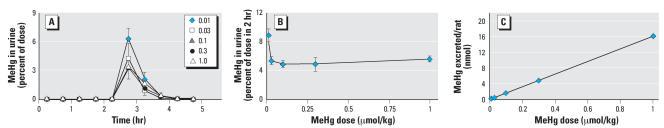
Effect of a standard dose of NAC (1 mmol/kg) on urinary excretion of [14C]MeHg. (A) Effect of NAC after treatment with various doses of [14C]MeHg (μmol/kg) over time. (B) Amount of [14C]MeHg excreted in urine 2 hr after NAC injection plotted against [14C]MeHg doses. (C) Actual amount of [14C]MeHg excreted in urine versus the amount injected; y = 16.133x + 0.0281; R2 = 0.9998. Values are mean ± SD; n = 4–5 rats in each group.